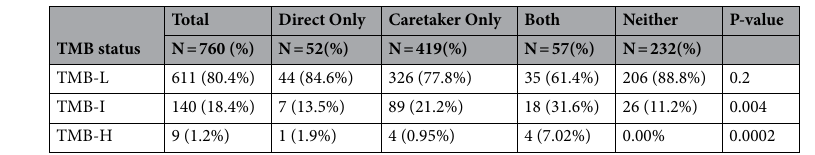
Table 2. Associations between DNA repair genetic aberrations and tumor mutational burden. TMB tumor mutational burden, TMB-H high TMB (≥ 19.5 mut/mb), TMB-I intermediate TMB (5.5–19.5 mut/mb), TMB-L low TMB (< 5.5